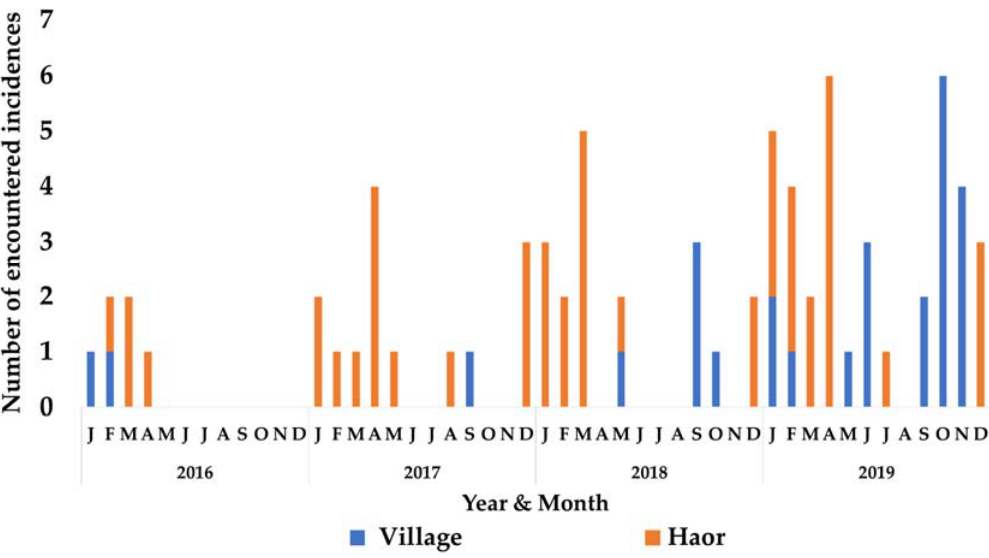
Figure 2. Monthly variation in human–fishing cat encounters in village (n = 27) and haor (n = 48) areas during the period 2016–2019.